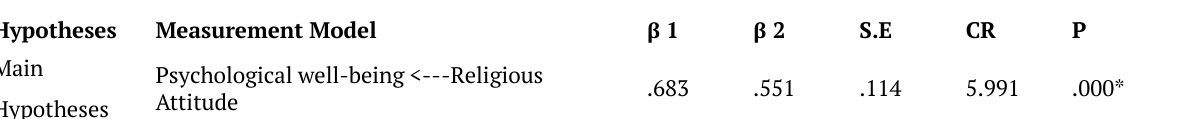
Table 4. Path Analysis Table